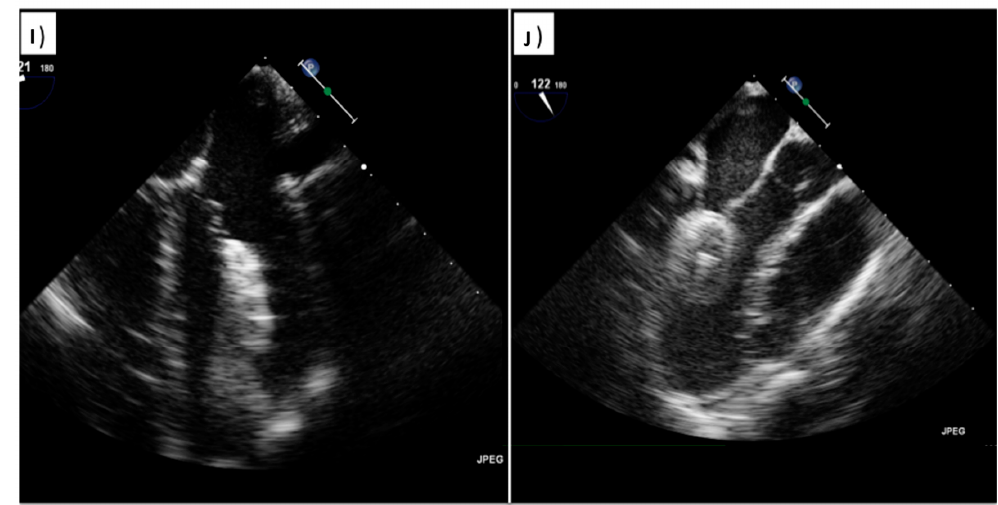
Figure 8. Complication after ASD closure. Examples of complication or sub-optimal procedural result after ASD closure. Please note in ( F ), the presence of shunt between the device and torus aorticus is to be compared with normal “intra-device” flow seen in ( G ). Device embolization to the left ventricular cavity is shown in ( I , J ). ASD = secundum type Atrial Septal Defect; LA = Left Atrium; RPV = Right Pulmonary Valve; SVC = Superior Vena Cava.